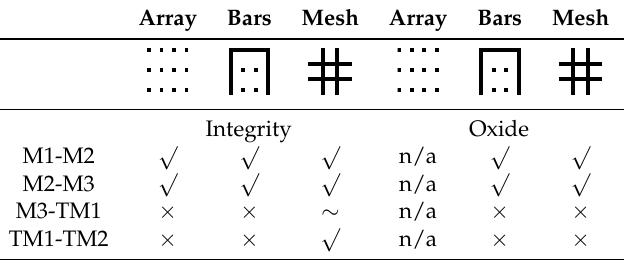
Table 4. Comparison of observed metal-via-metal stack performance for different via patterns and metal layers: integrity of the mechanical connection and preservation of the silicon oxide enclosed by vias. Array Bars Mesh